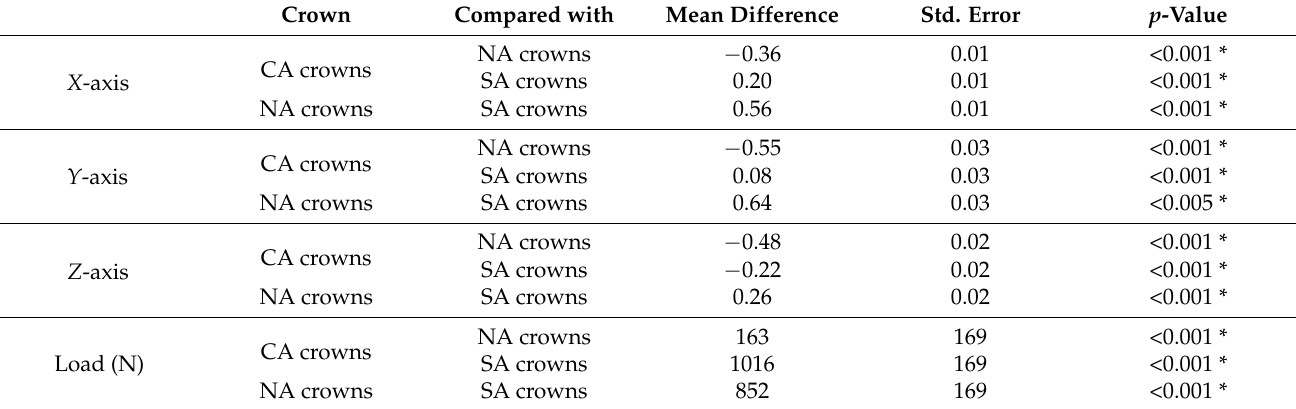
Table 2. Post hoc test with p -values among anterior crowns at different axes.